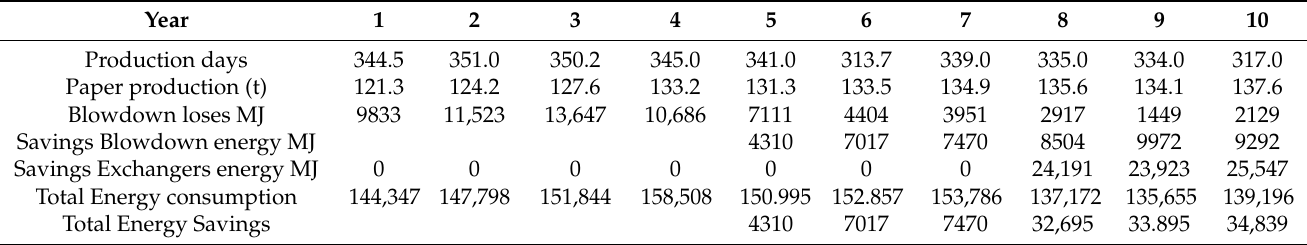
Table 3. Total energy savings over 10 years.